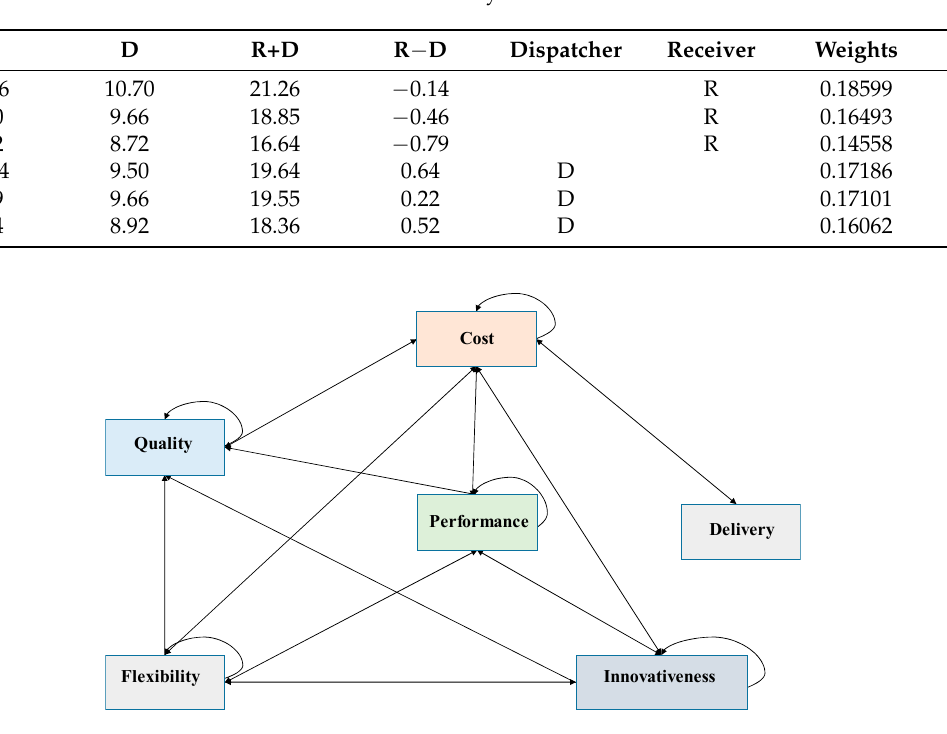
Table 7. Final results of DEMATEL analysis.